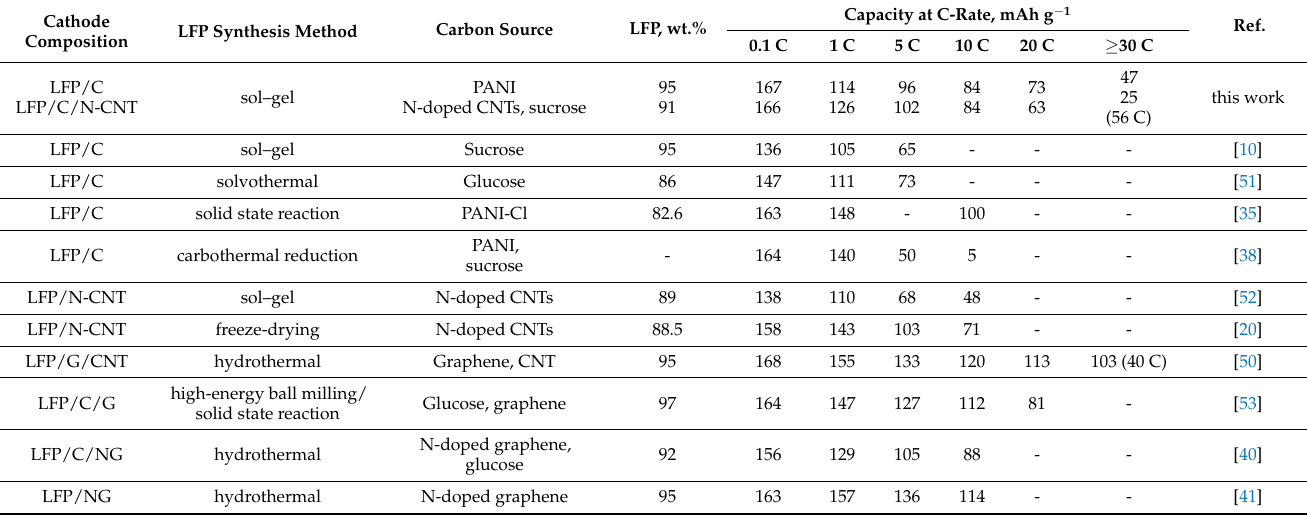
Table 2. Comparison of electrochemical performances of LFP/C